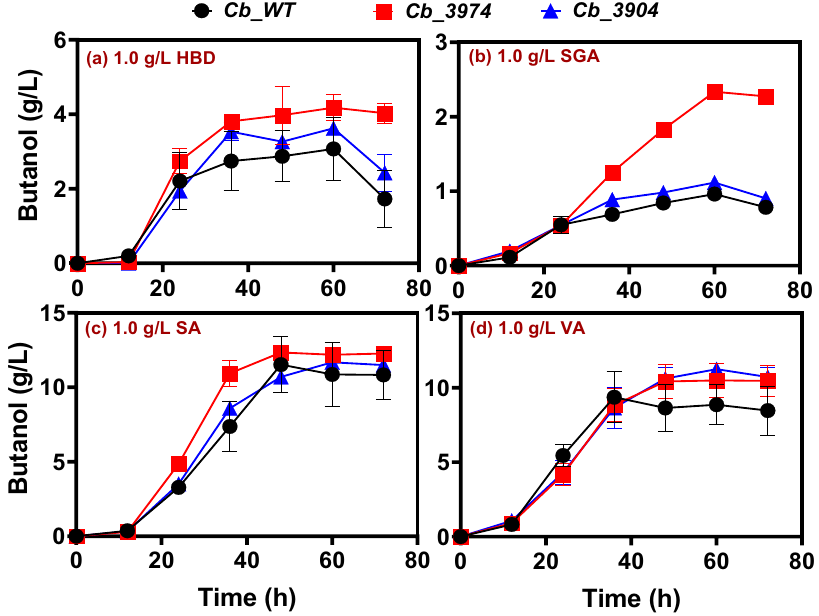
Figure 9. Butanol concentrations in cultures of Cb _3974, _3904, and _wild type during ABE fermentations supplemented with 1.0 g/L 4-hydroxybenzaldehyde (4-HBD), syringaldehyde (SGA), syringic acid (SA), and vanillic acid